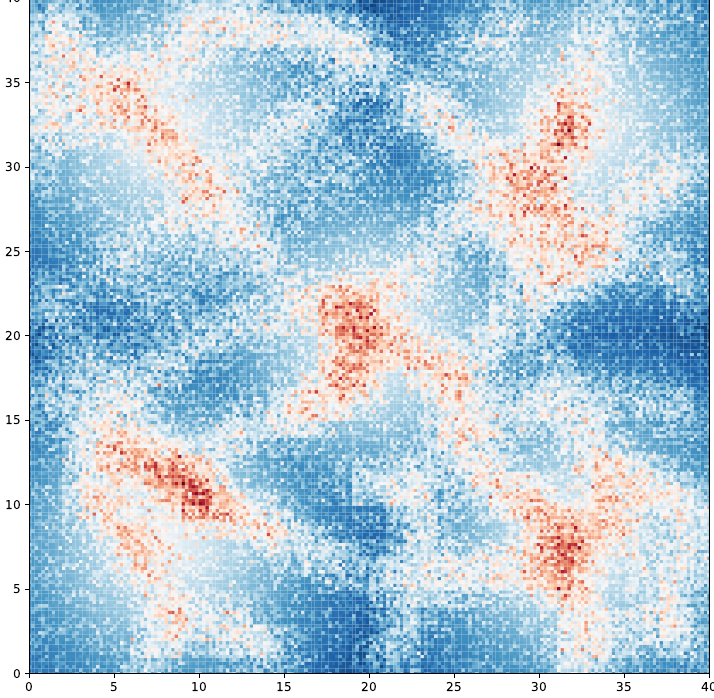
Figure 7. The heatmap of the vehicles trajectories of